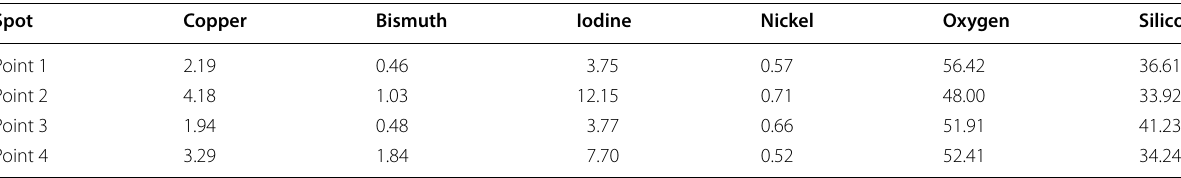
BiI /NiO substrate shown in Fig. 8f 3 6